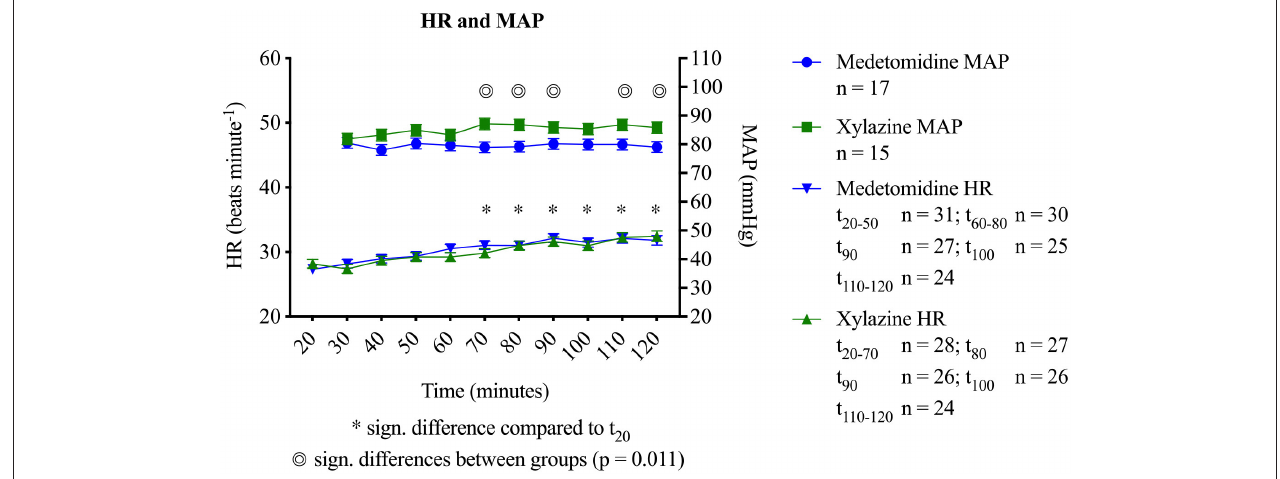
Significant differences (p < 0.05) between groups are indicated by * and significant changes compared to B or t 30 in the same group are indicated by #. Na + ,ionizedsodium;K + ,ionizedpotassium;Ca 2 + ,ionizedcalcium;Cl − ,ionizedchlorine;B,Baseline;I,Induction;R,Recovery;S,Standing;t 30 − 150 ,timepointsinminutesafterinduction.